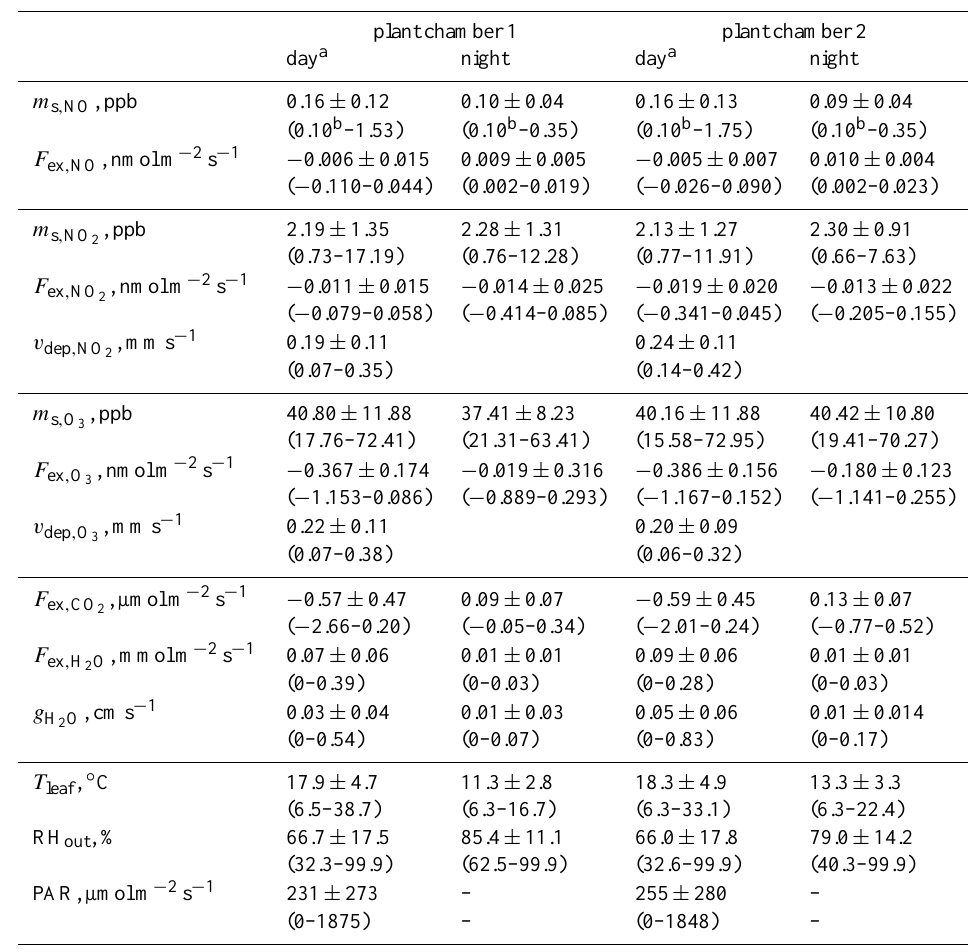
Table 2. Overview of chamber measurements for spruce ( Picea abies ). Given are mean data from 4min average values from day and night measurements. Values in brackets present the range of